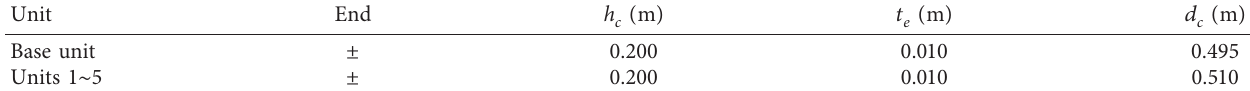
Table 1: Cementing parameters of the porcelain arrester specimen.